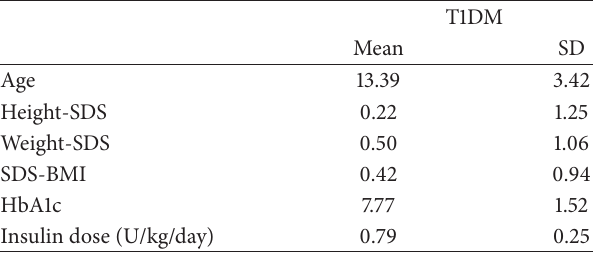
Table 1: Clinical data of children with